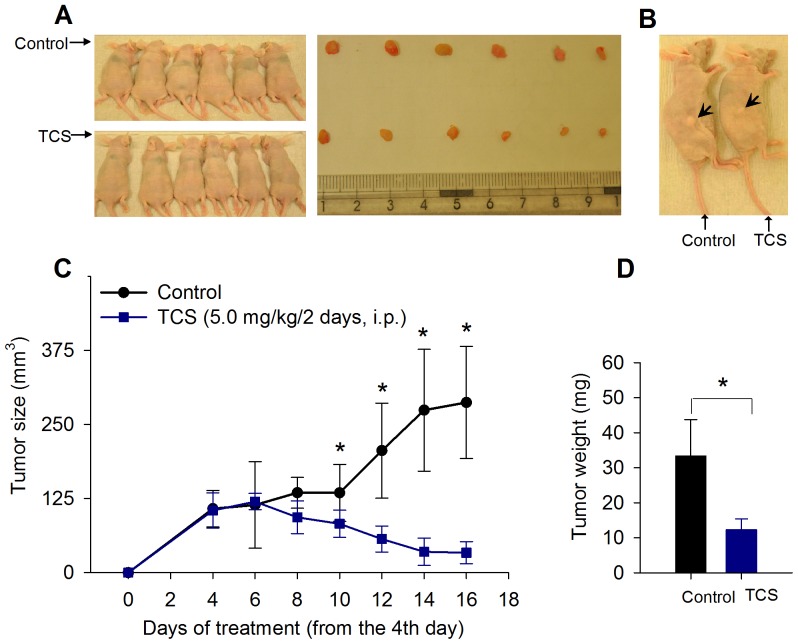
TCS inhibits MDA-MB-231 xenograft growth in nude mice.A. Twelve female BALB/c nude mice received an injection of MDA-MB-231 cells and were divided into 2 groups. TCS was administered at a dose of 5.0 mg/kg every other day for a total of 7 injections. On day 16, mice were sacrificed and excised tumors are shown in the right panel. The dose applied had no detectable toxicological effects on nude mice, such as changes in body weight. B. A representative comparison between a TCS-treated mouse and a PBS-treated control mouse. C. TCS significantly reduced tumor volume from the 6th day of treatment onward. D. The mean tumor weight in TCS group was smaller than that of control. For asterisks in C and D, p<0.05.